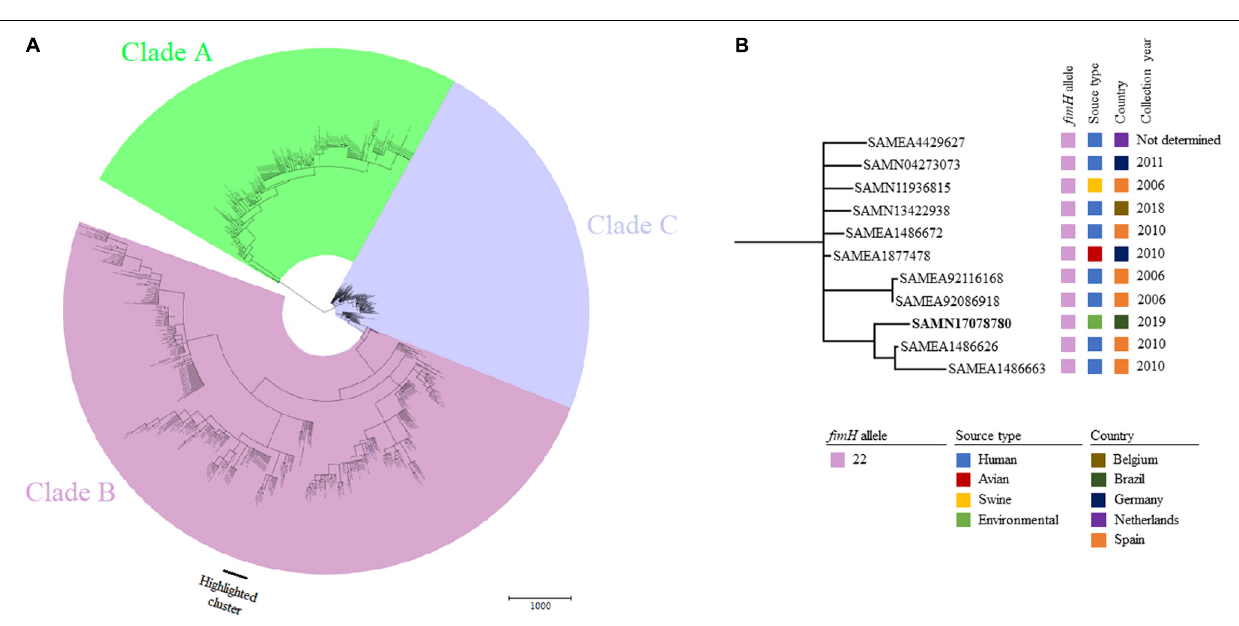
( cpxA ), crystal violet ( mdtABCEFGHKNOP , tehAB ), ethidium ( gadCEWX ), hydrogen peroxide ( cpxA , fetAB , sitABCD ),